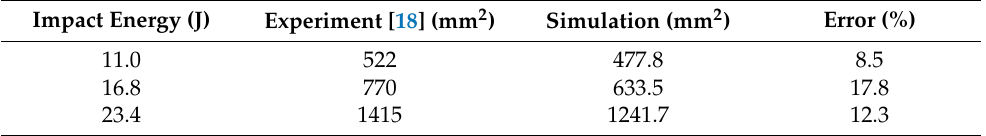
Table 4. Comparison between experiment and simulation for the damage projection area.